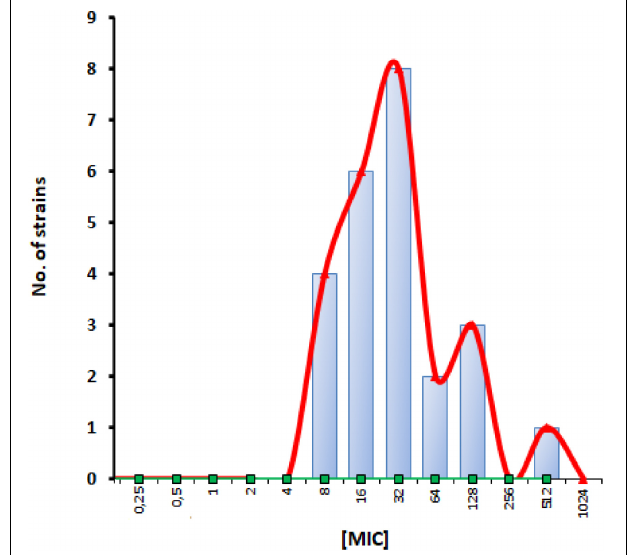
FIGURE 1 | Apramycin MIC distribution for P. aeruginosa CF strains. Twenty-four strains were examined in this study. Vertical bar designates an epidemiological cut-off value of 64